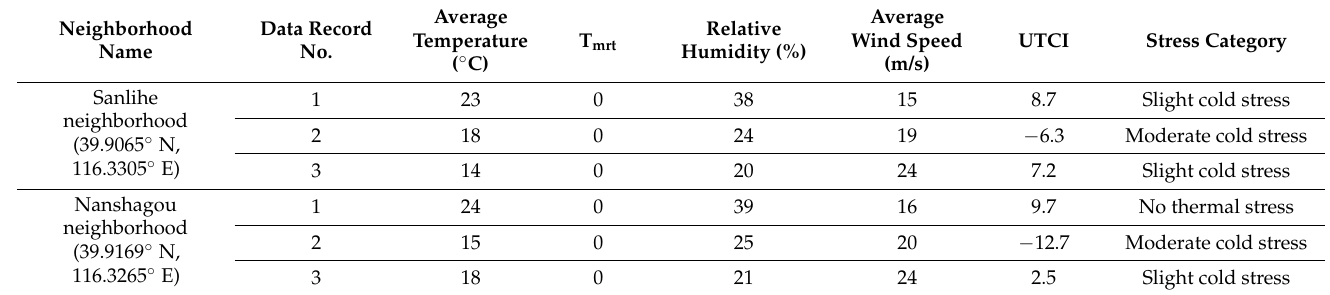
Table 1. Outdoor thermal comfort description of the neighborhoods (April 2021,